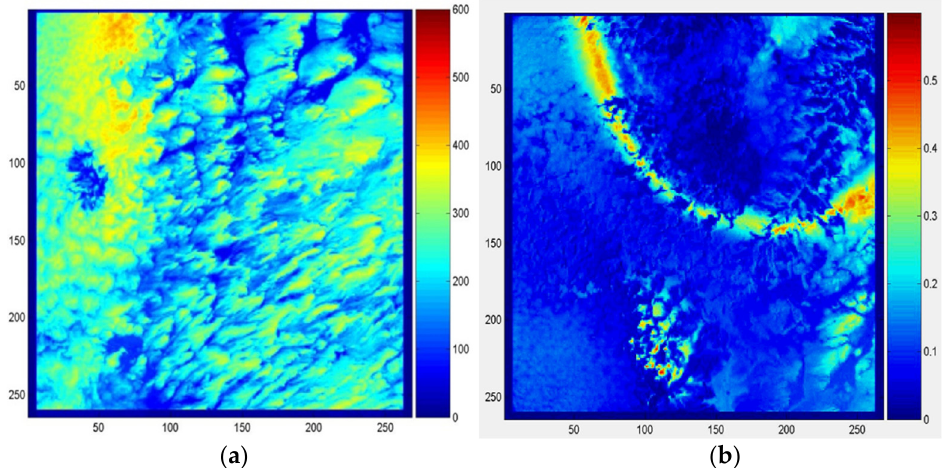
Figure 5. The cloudbow observed by polarization imager, ( a ) shown by total reflectance ( I ), with the color indicating the DN, and ( b ) shown by polarized reflectance ( I pol ). The abscissa and ordinate of the image represent the row and column numbers in the frame of instrument coordinates.